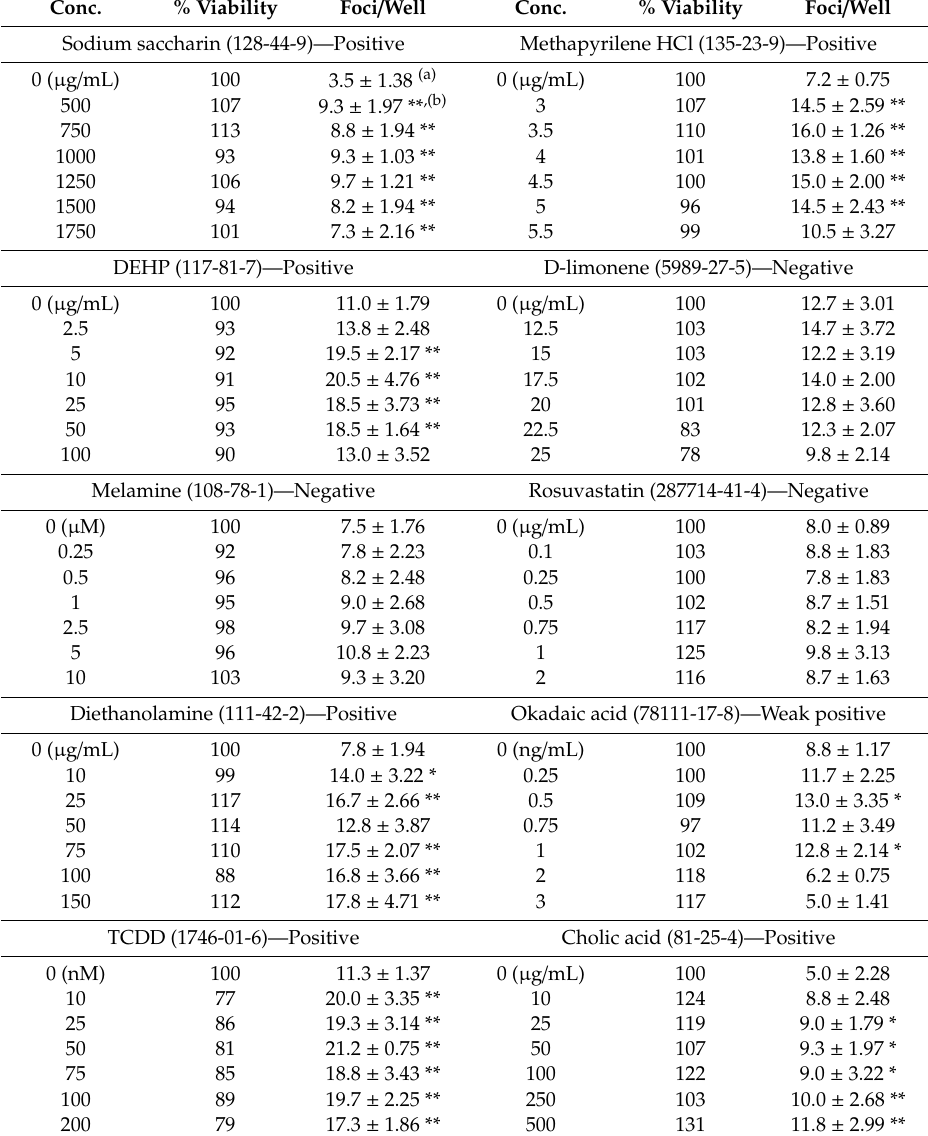
Table 3. Among the 10 NGTXCs, three (D-limonene, melamine, and rosuvastatin) showed negative results in the promotion test. Sodium saccharin, methapyrilene, DEHP, diethanolamine (DEA), TCDD, and cholic acid induced a more than two-fold increase in foci formation, while okadaic acid led to a relatively weak increase. Table 3. Bhas 42 cell transformation assay (Promotion